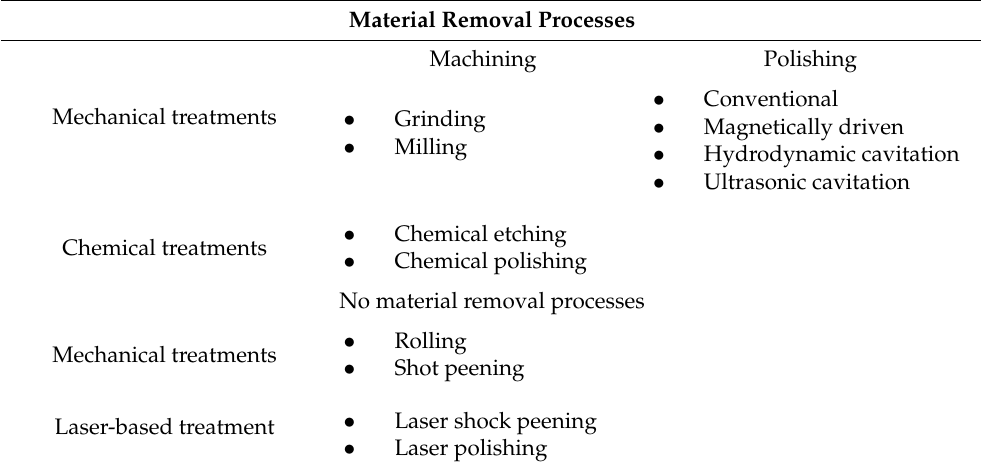
Table 2. Various post-processing techniques applied in